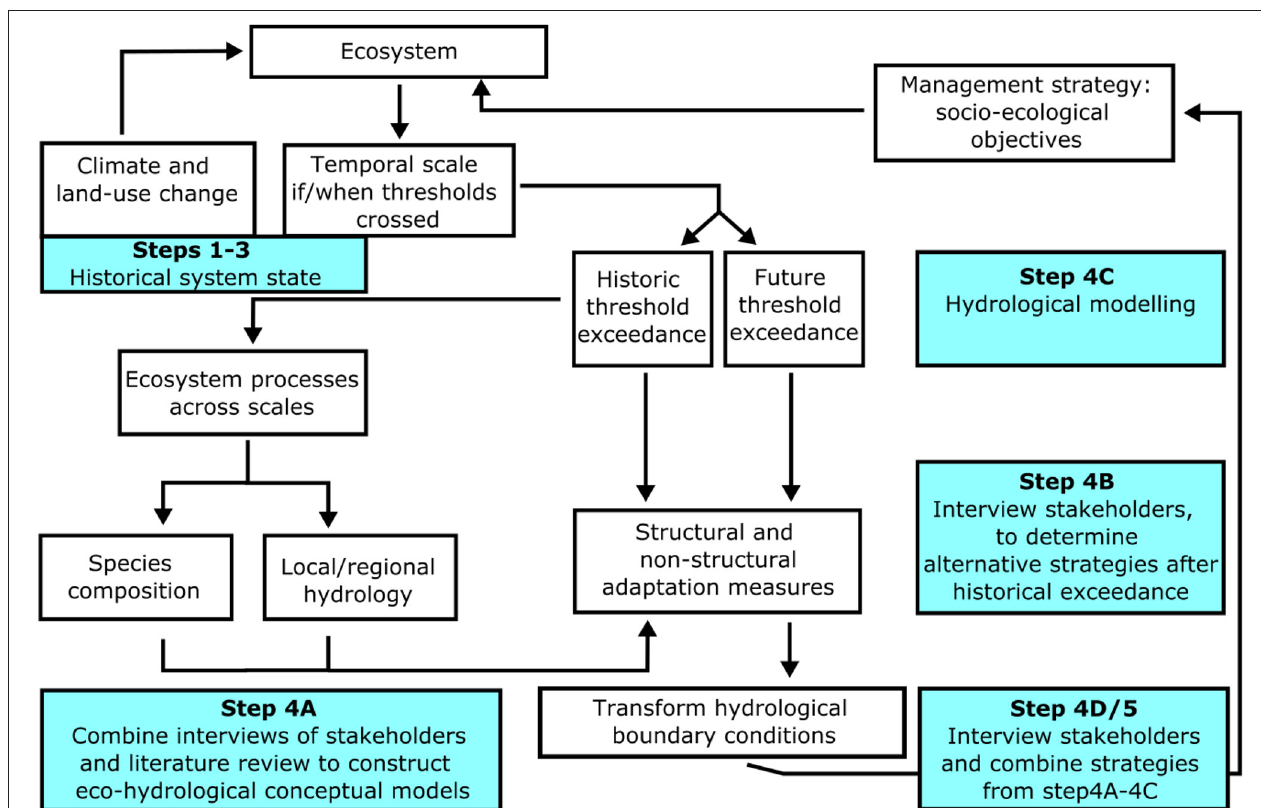
FIGURE 1 | An overview of the ATP methodology applied to the case study area Forrestdale